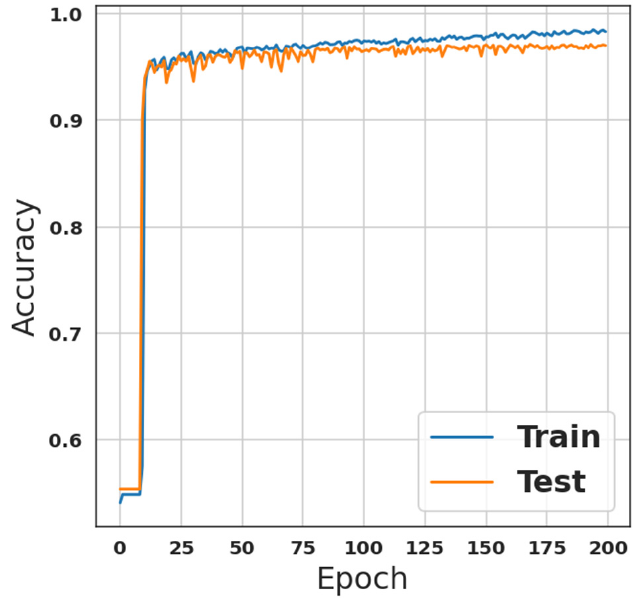
Figure 3. ANN-model accuracy during training-phase.